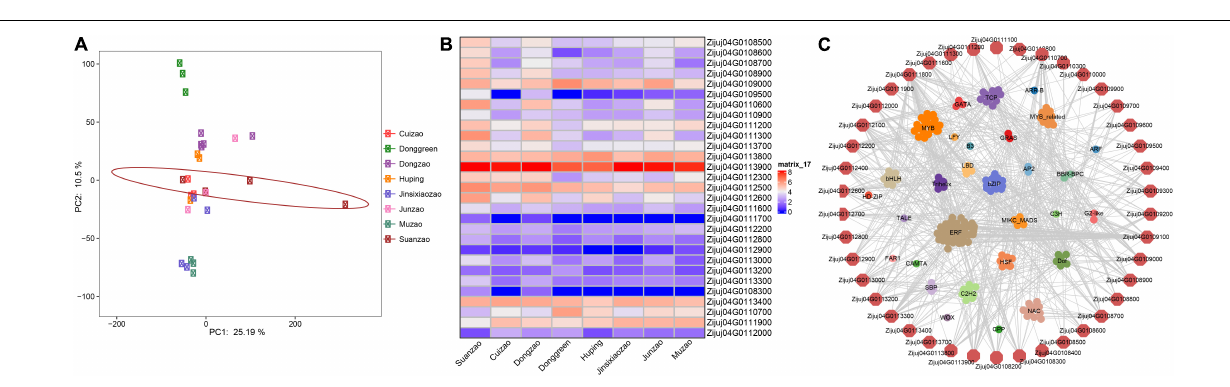
FIGURE 5 | Expressions of genes in fruits of jujube accessions. (A) PCA results of 8 jujube accessions based on gene expressions in fruits. (B) Heatmap of expressions of genes in fruits, which are under strong selection on chromosome 4 in the wild. (C) Networks of transcription factors which are predicted for the genes under strong selection on chromosome 4 in the wild, based on PlantRegMap